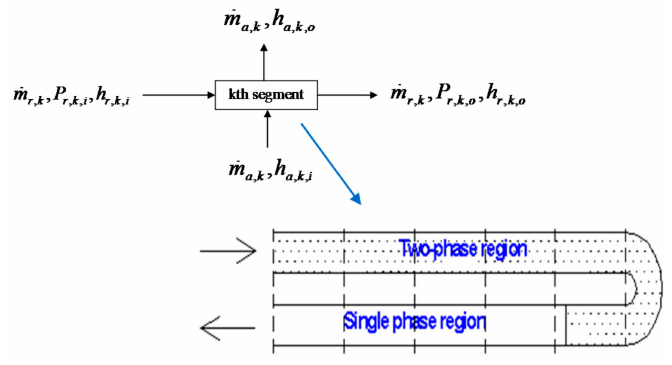
Figure 4. Segment-to-segment modeling